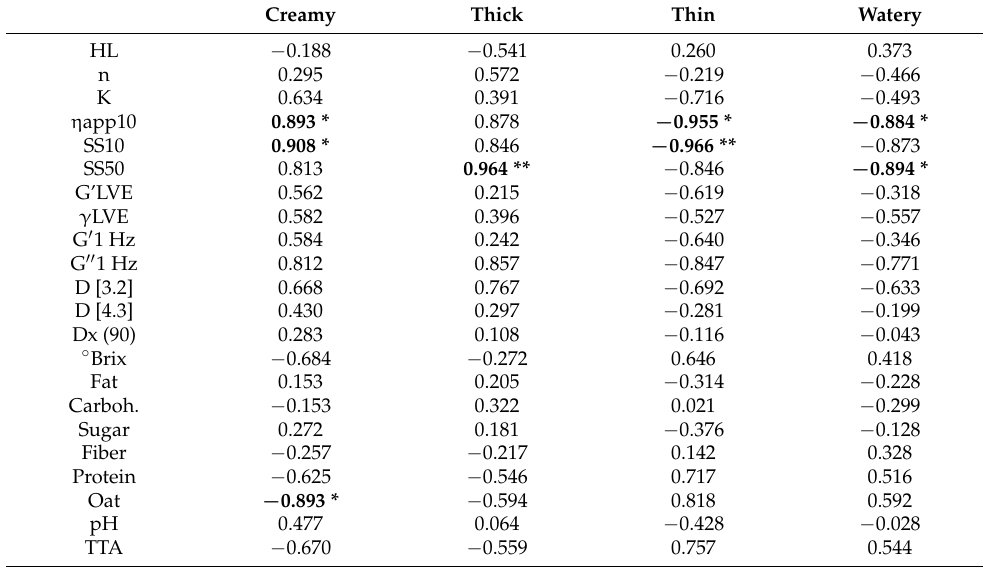
Table A1. Pearson correlations between physicochemical and mouthfeel parameters in plant-based yogurts ( n = 5). Correlation coefficients in bold are significant at p < 0.05 (*) and at p < 0.01 (**). Creamy Thick Thin Watery HL −